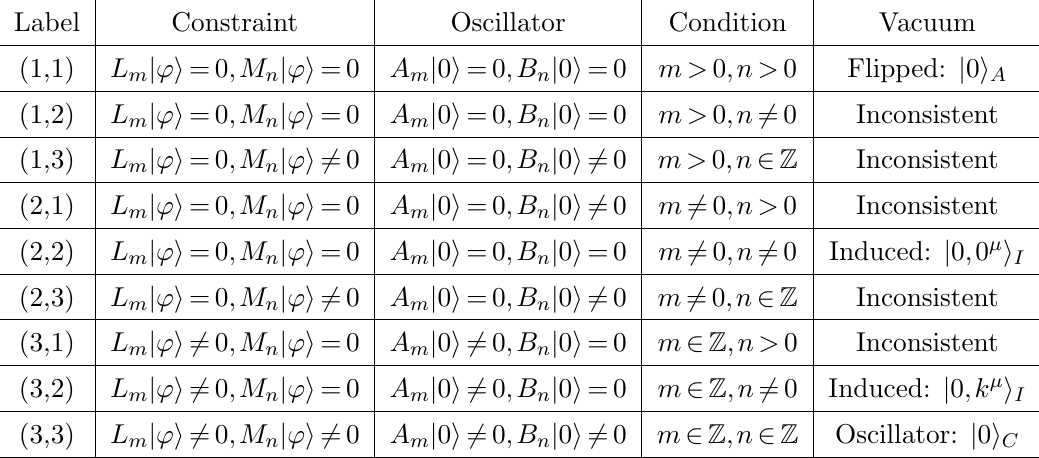
Table 1 . Quantum constraints on a physical state j ’ i leading to di(cid:11)erent